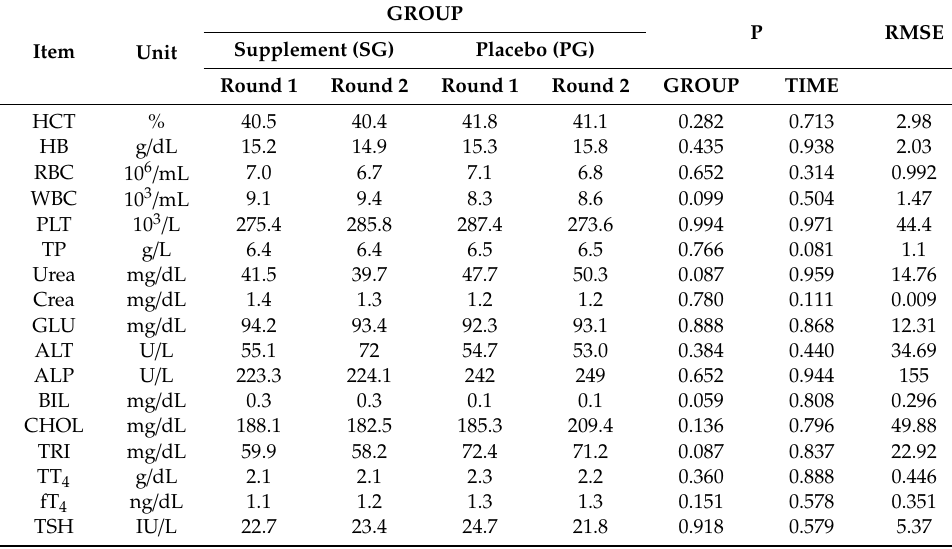
Table 1. Haematological, biochemical and hormonal traits in supplemented and placebo groups before and after the treatment period (rounds 1 and 2, respectively). Results were subjected to